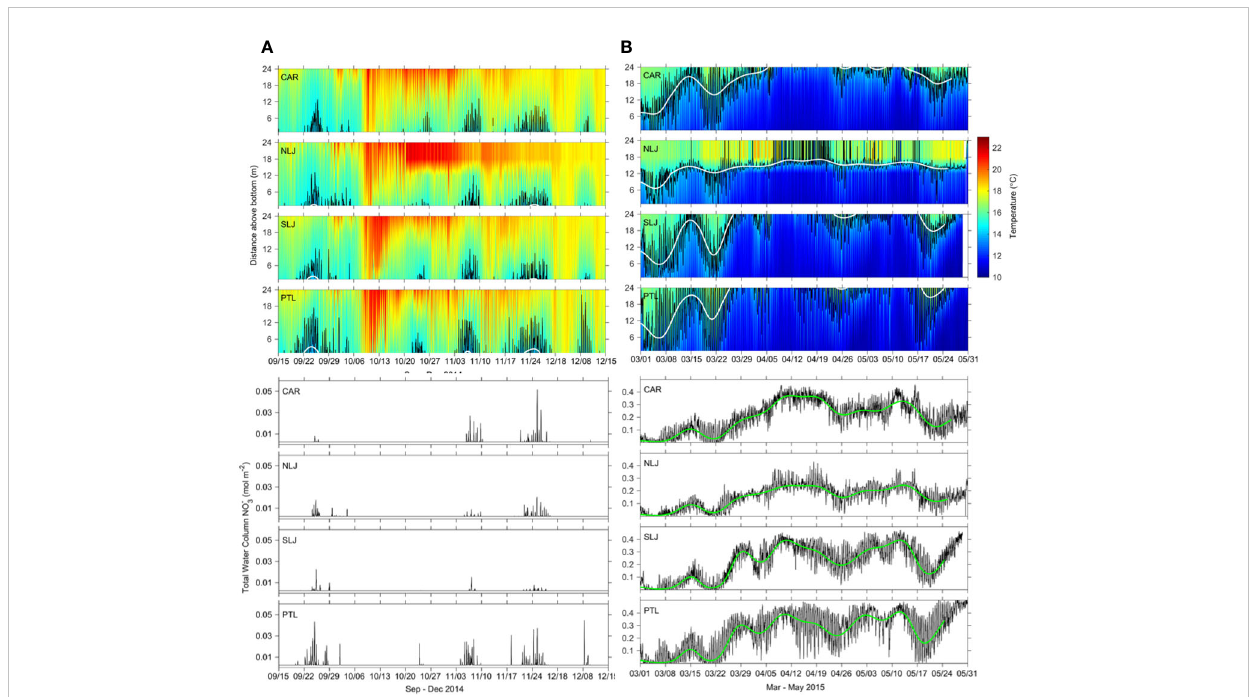
FIGURE 5 Expanded views of data seaward of 4 kelp forest study sites shown in Fig 4 for two time periods: (A) 15 Sep - 15 Dec 2014 and (B) 1 Mar – 31 May 2015. Upper panels in A and B show temperatures at 1 min intervals for the lower 24 m of the water column measured at 36 m bottom depth. Black lines indicate position of the 14.5 °C isotherm at 1 min intervals, white lines indicate position of the 14.5 °C isotherm for 10-d fi ltered data. Lower panels show total water column integrated NO 3- for 1-min data (black lines) and 10-d fi ltered data (green lines).